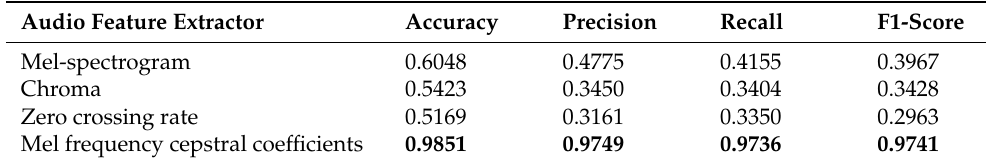
Table 10. Overall classification report of DNN machine learning model for aphasia level classification using different speech feature extraction techniques for 10 s audio